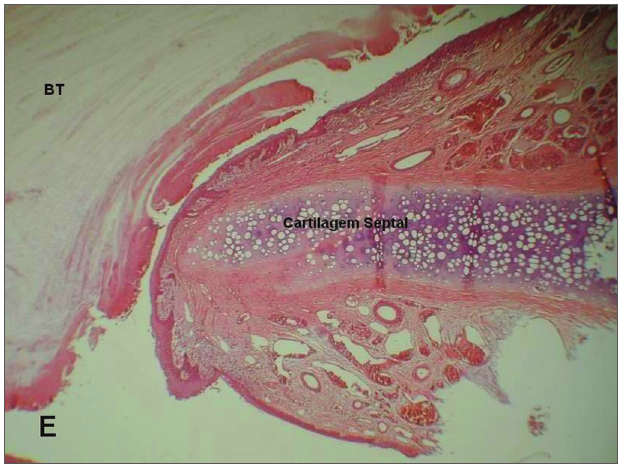
Figura 7. Fotomicrografia de lâminas histológicas de septo; E=Septo roto e Bionext® (10x); BT= Bionext® Coloração HE.